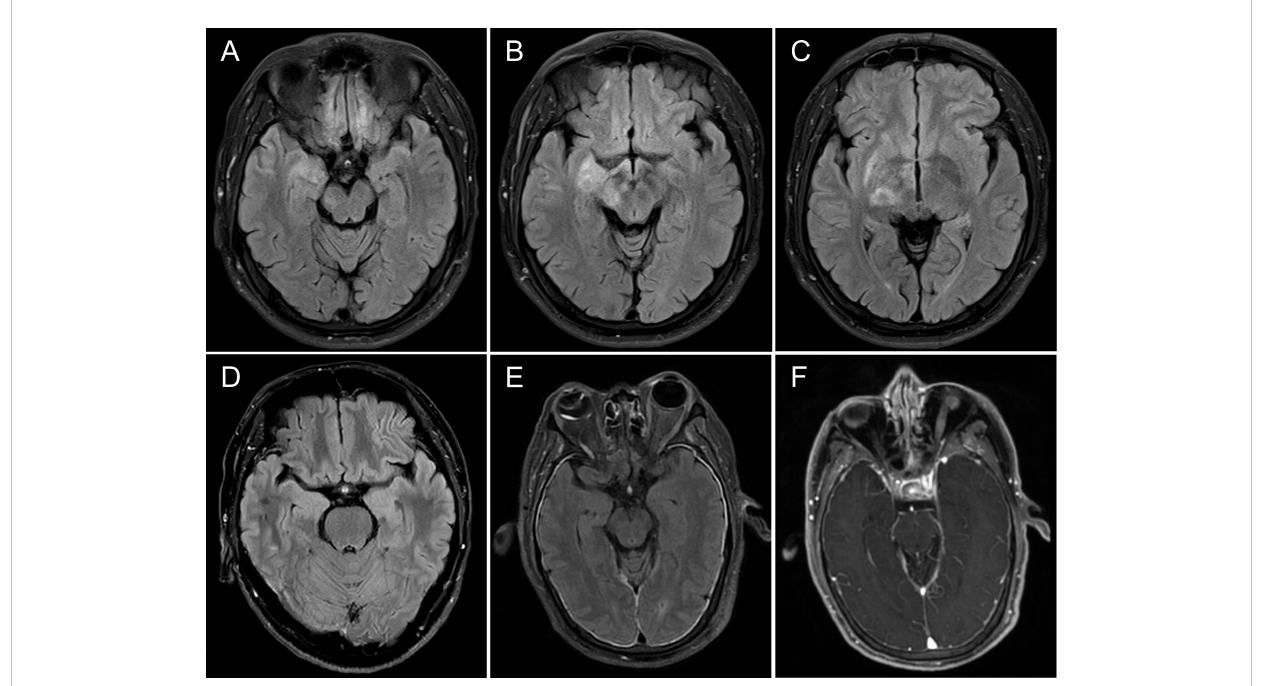
FIGURE 1 MRI of representative patients with anti-mGluR5 encephalitis in the current study. (A-C) Brain MRI of patient 2. Initial brain MRI at disease onset showed T2/ fl uid-attenuated inversion recovery hyperintensities of the right mesiotemporal lobe (A) , cerebral peduncle (B) , thalamus, and putamen (C) . (D) Brain MRI of patient 1. Brain MRI at disease onset and at the fi rst relapse was normal, but at the second relapse, brain MRI showed T2/ fl uid- attenuated inversion recovery hyperintensity of the bilateral hippocampi. (E, F) Brain MRI of patient 5. Initial brain MRI at disease onset showed diffuse T2/ fl uid-attenuated inversion recovery hyperintensity of the meninges and enhanced on post-gadolinium T1-weighted